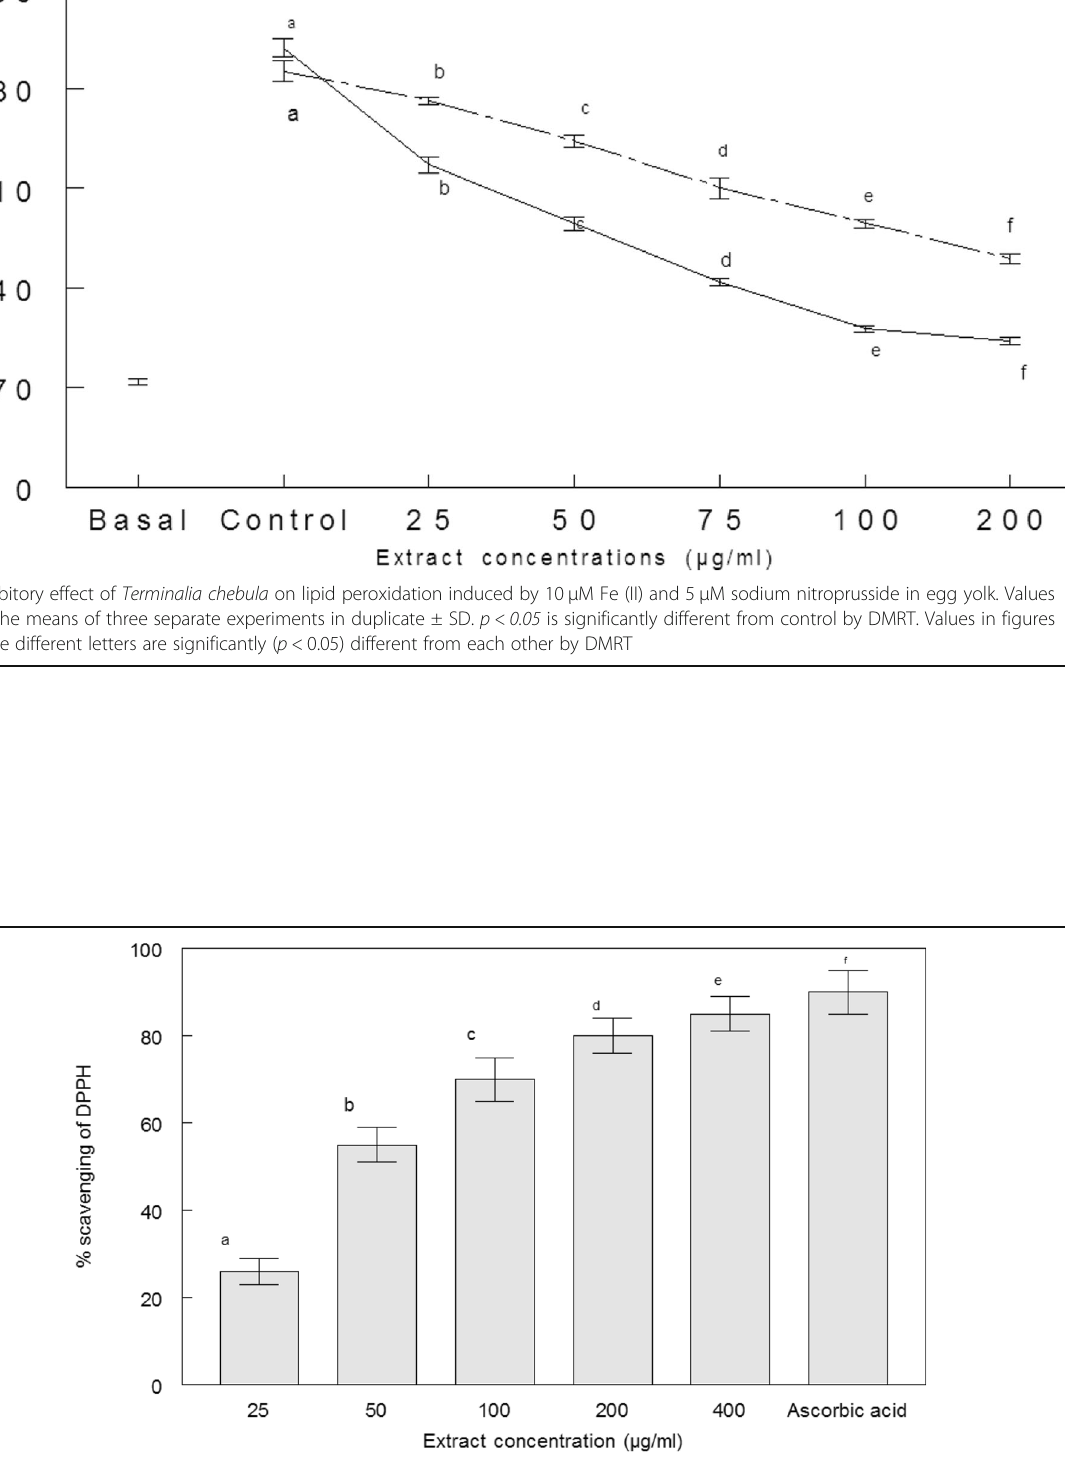
Fig. 3 DPPH radical scavenging activity of aqueous extract obtained from fruit of Terminalia chebula. Ascorbic acid at concentration of 100 μ g/ml. Values are means±SD ( n = 3). Values in figures which share different letters are significantly ( p < 0.05) different from each other by DMRT